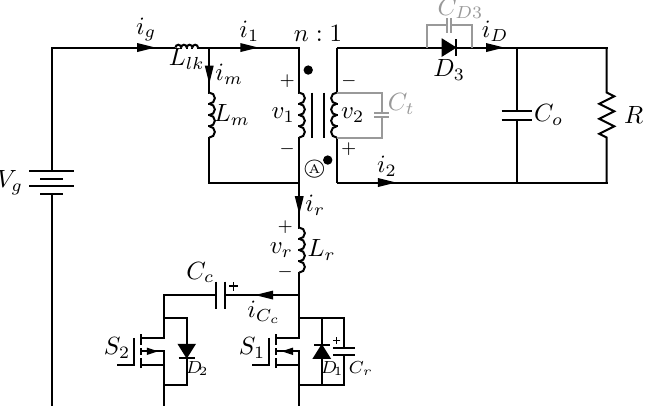
Figure 2. ACF converter with parasitic elements.